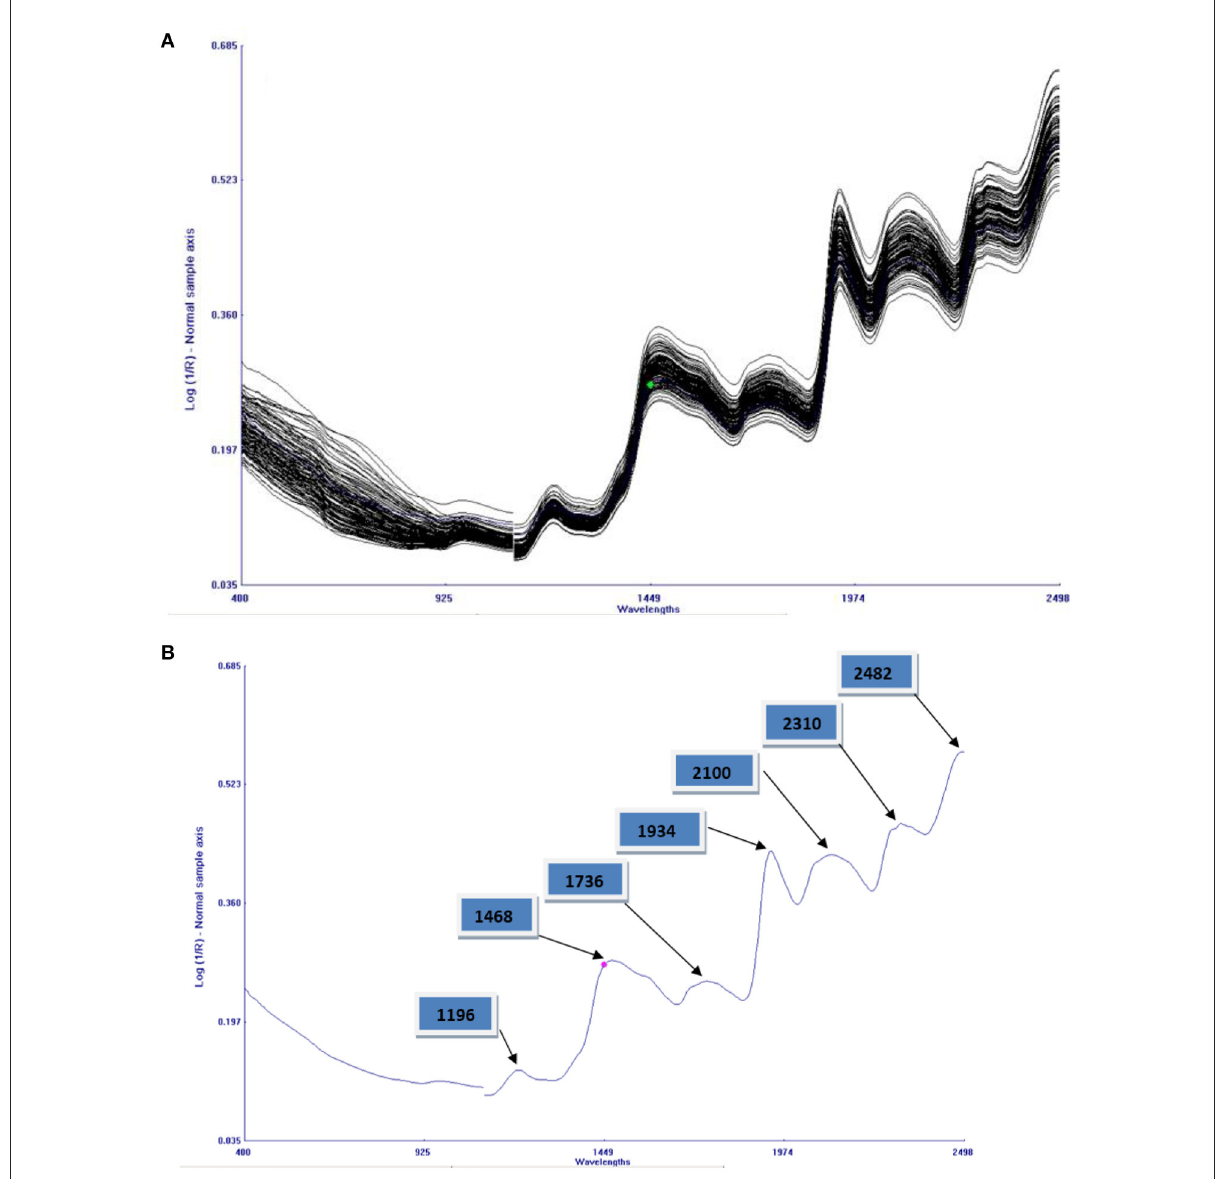
FIGURE2 (A) A combined plot of reflectance spectra of all the entire 121 cowpea germplasm. (B) An average reflectance spectrum of cowpea homogenized flour with seven absorption bands.